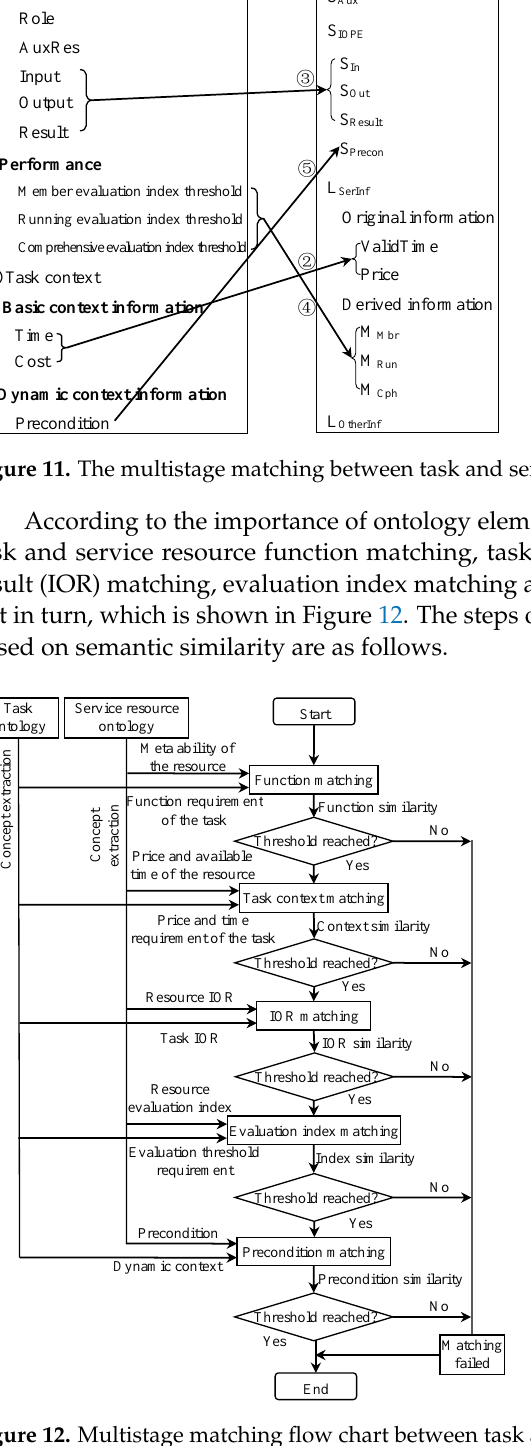
Figure 12. Multistage matching flow chart between task and service.